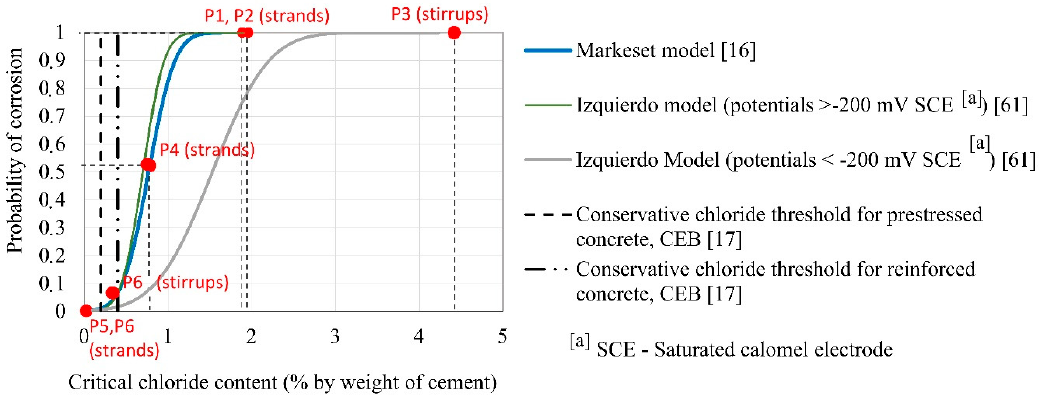
Figure 15. Probability of reinforcement corrosion calculated based on the Markeset statistical model.